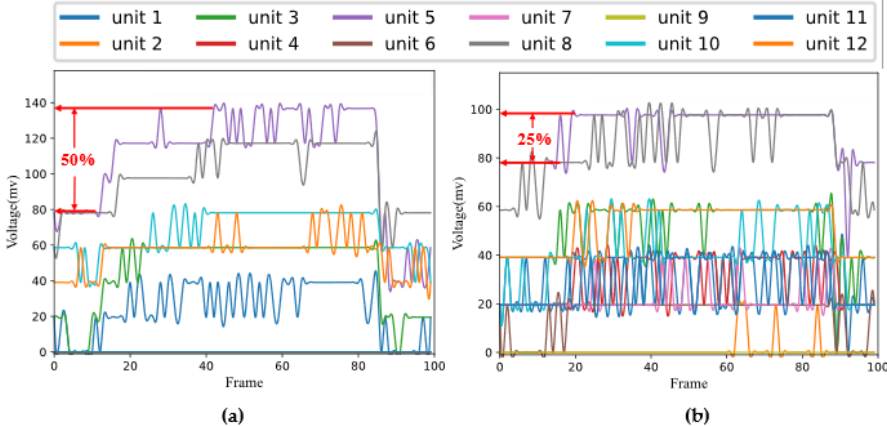
Figure 8. The output voltage time sequence signals of 12 sensitive units from the two sensor arrays for the two objects: ( a ) The voltage time sequence signals collected for the glue set; ( b ) The voltage time sequence signals collected for the sponge.